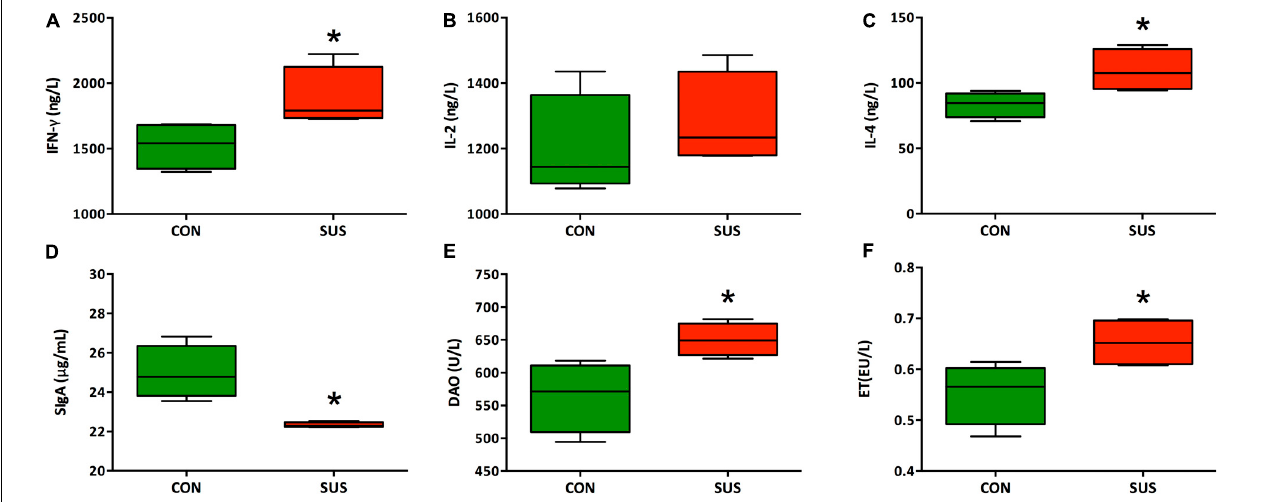
FIGURE 3 | (A–F) Effects of simulated weightlessness on the levels of IFN- γ , IL-2, IL-4, DAO, and ET in serum and SIgA in ileum. CON, control group; SUS, simulated weightlessness group. Data are representative as median with absolute range (min. and max.) and interquartile ranges Q25 and Q75. ∗ P < 0.05, compared with the control group.